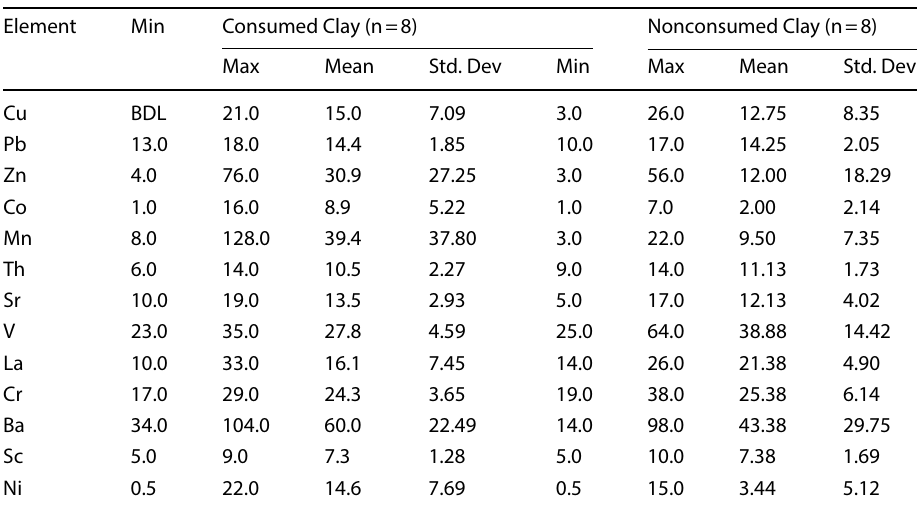
Element Min Consumed Clay (n =